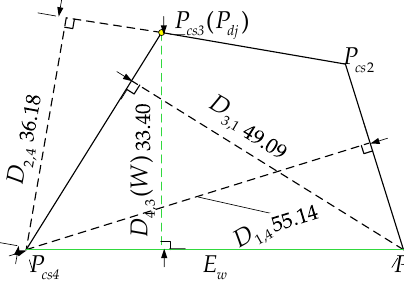
Figure 9. The width of intersection CPG.